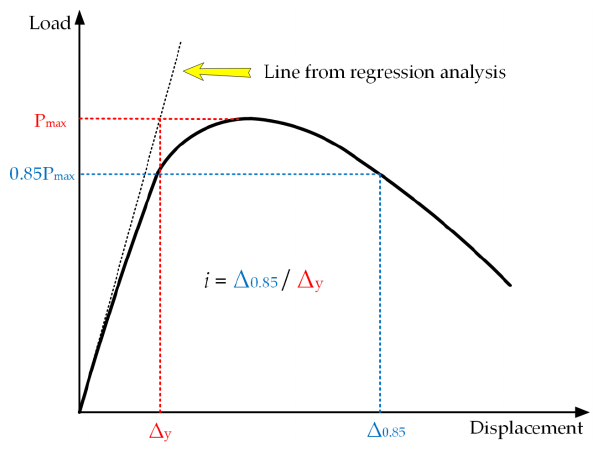
Figure 17. Definition of the displacement–ductility ratio [29].